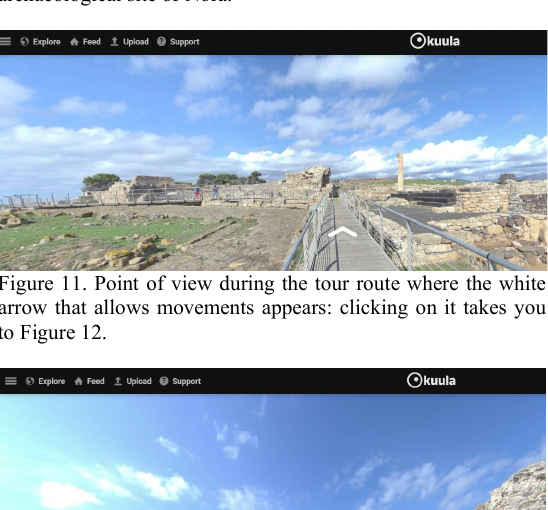
Figure 10. The start of the virtual tour from the plan of the archaeological site of Nora.